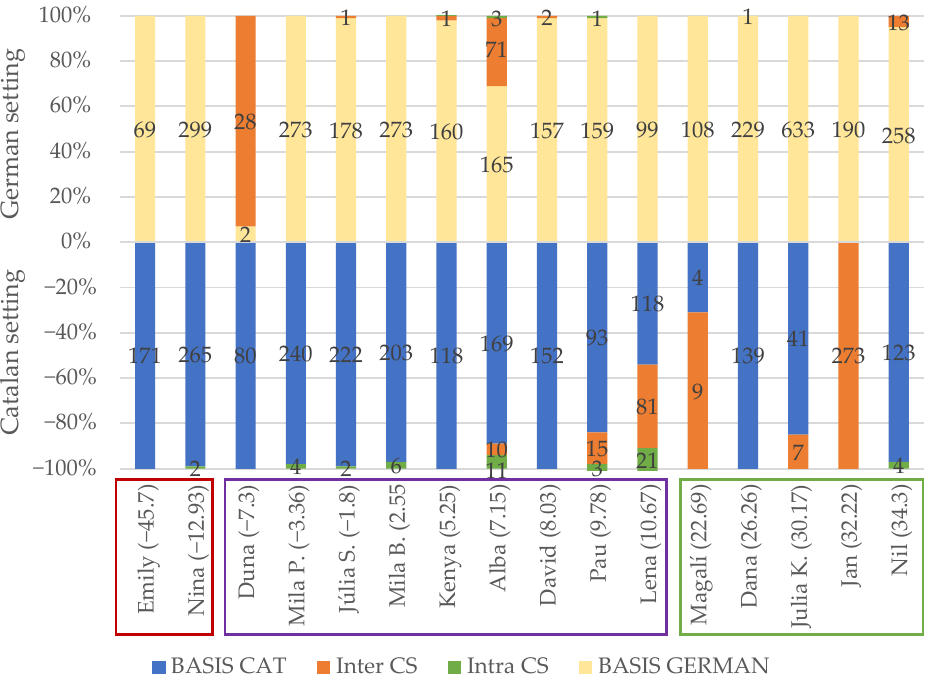
Figure 11. Fluency and inter- as well as intrasentential CS according to children’s FluencyD values (Child (FluencyD)).